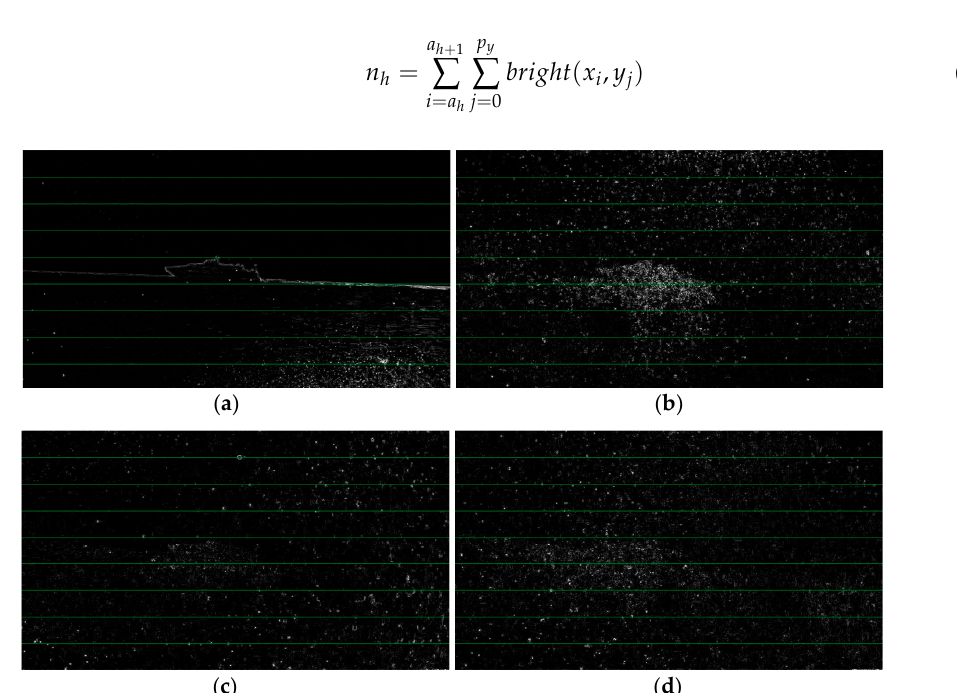
sea–sky line in the image is little, while for the green-water scene, the edge information of